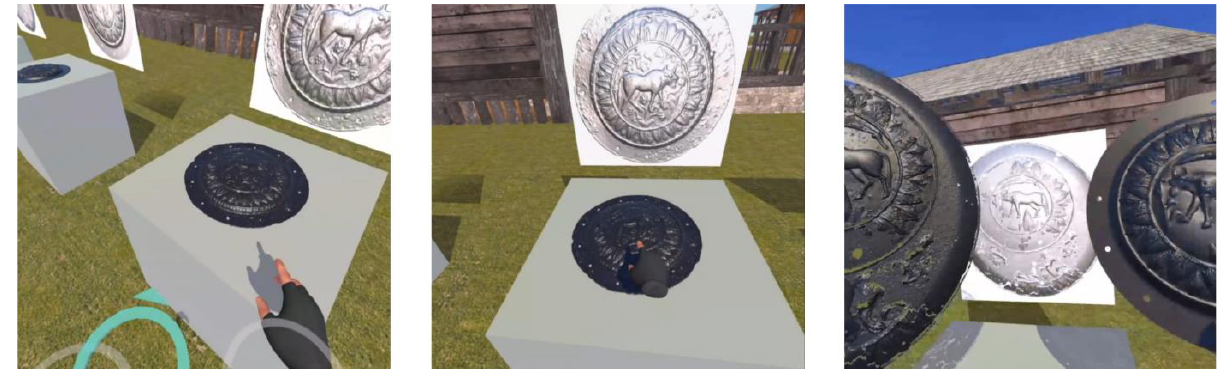
Figure 24. Overview of the VR application developed in Unity.